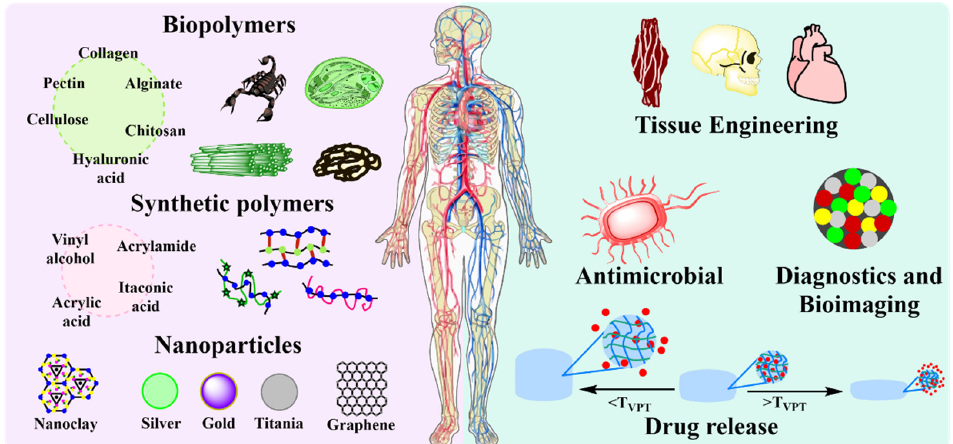
Figure 5. Schematic representation of the biomedical applications of PNVCL hydrogels in the last decade.